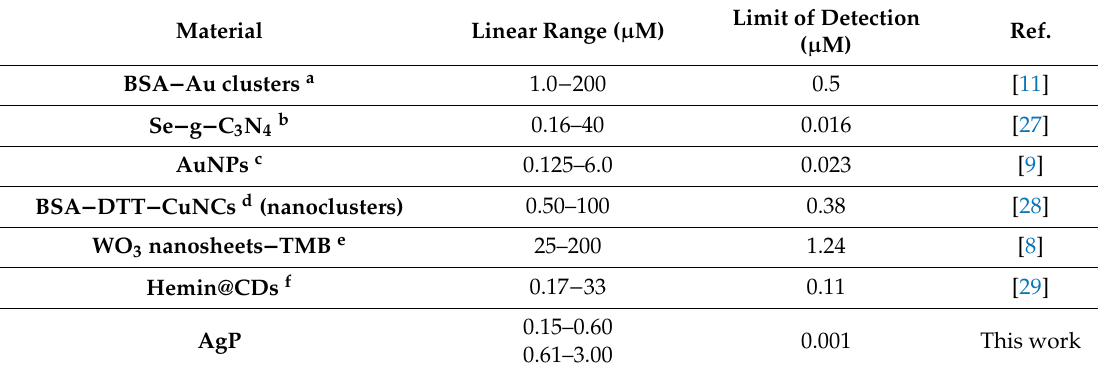
Figure 5. UV-Vis absorption spectra in the presence of different concentrations of Xan. Inset: ( a ) The colorimetric response upon addition of Xan; ( b ) the relationship between the absorbance change ( Δ A) and the concentration of Xan. Table 1. Comparison of different colorimetric sensors for detection of Xan.